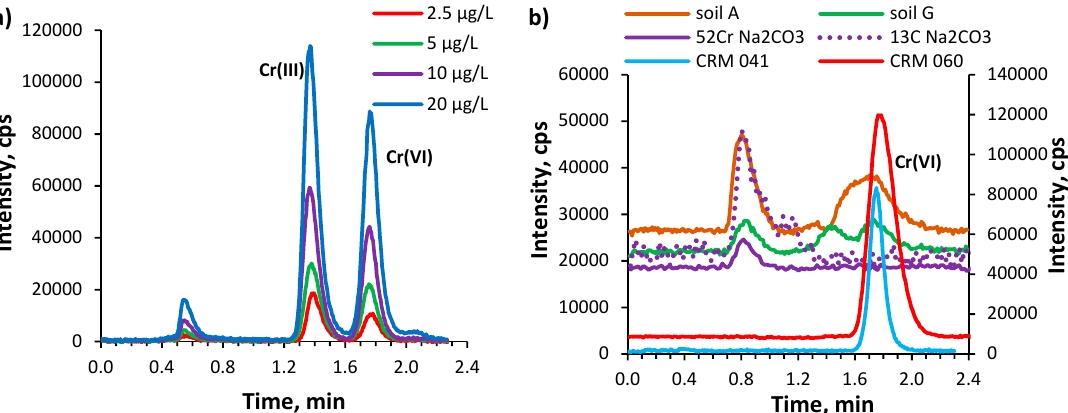
Figure 2. ( a ) Typical chromatogram for Cr(III) and Cr(VI) standards in diluted Na 2 CO 3 obtained using optimized HPLC-ICP MS procedure (see Table 1), recorded at m / z 52; ( b ) Chromatogram for chromium species in alkaline extracts of mineral soil A (4-fold diluted), organic soil G (20-fold diluted) and certified reference materials CRM 041 (100-fold diluted) and CRM 060 (400-fold diluted), recorded at m / z 52. Chromatogram for Na 2 CO 3 (20-fold diluted) was recorded at m / z 52 for chromium and at m / z 13 for carbon (dotted line). Additional right axis for CRM 041 and CRM 060.